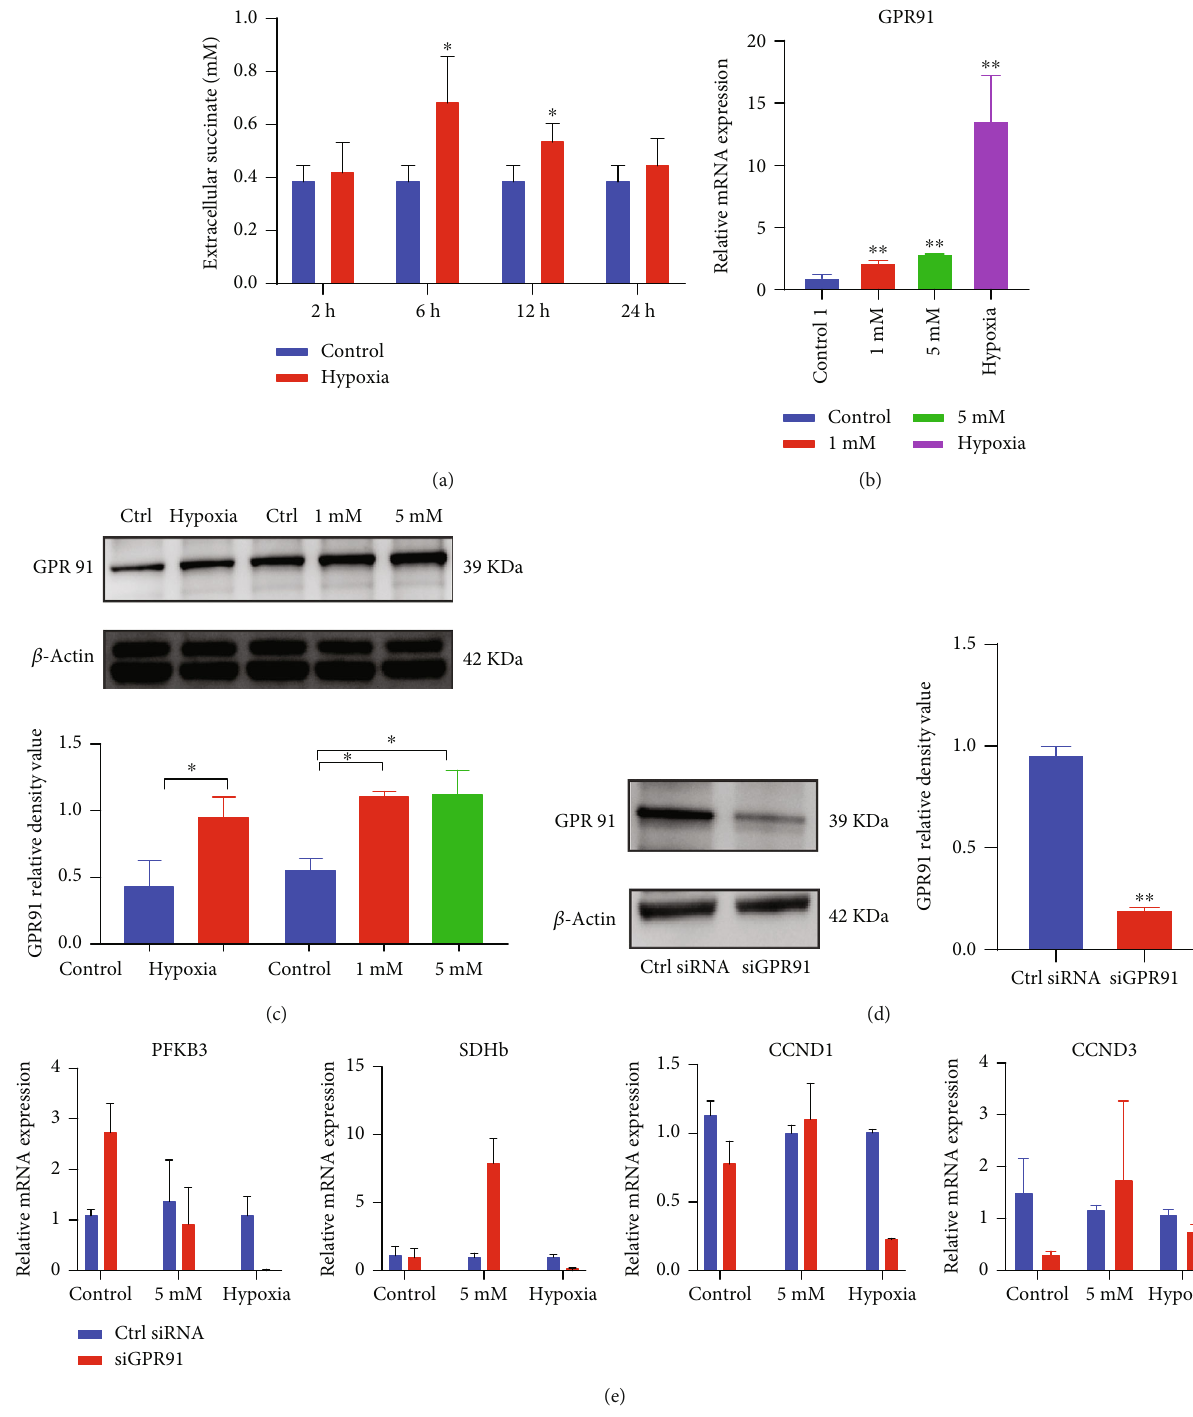
Figure 6: Succinate supplement triggered the GPR91-dependent and GPR91-independent pathway. The extracellular succinate concentration in supernatant was detected in hypoxia-cultured cells (a). The expression of GPR91 was analyzed by qPCR and western blot at 4h and 24h, respectively (b, c). Lentivirus-based gene interference was utilized to knock down GPR91 (d). Gene transcription was determined by qPCR at 4h (e). ∗ p < 0 : 05 , relative to control; ∗∗ p < 0 : 01 , relative to